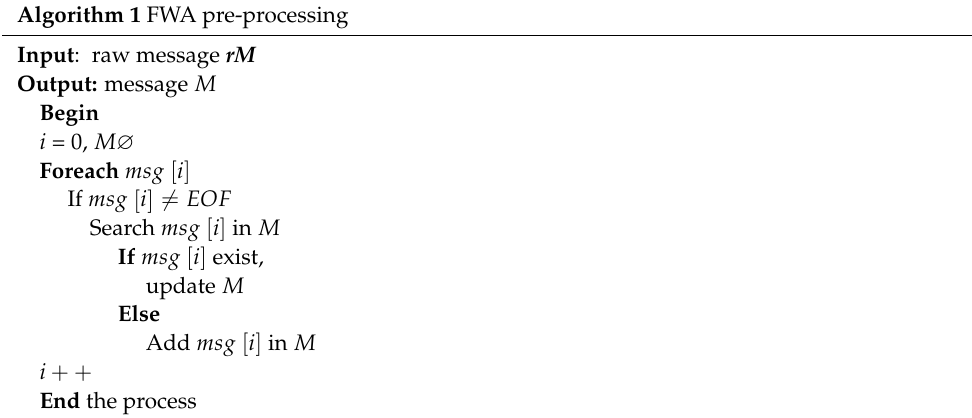
Algorithm 1 FWA